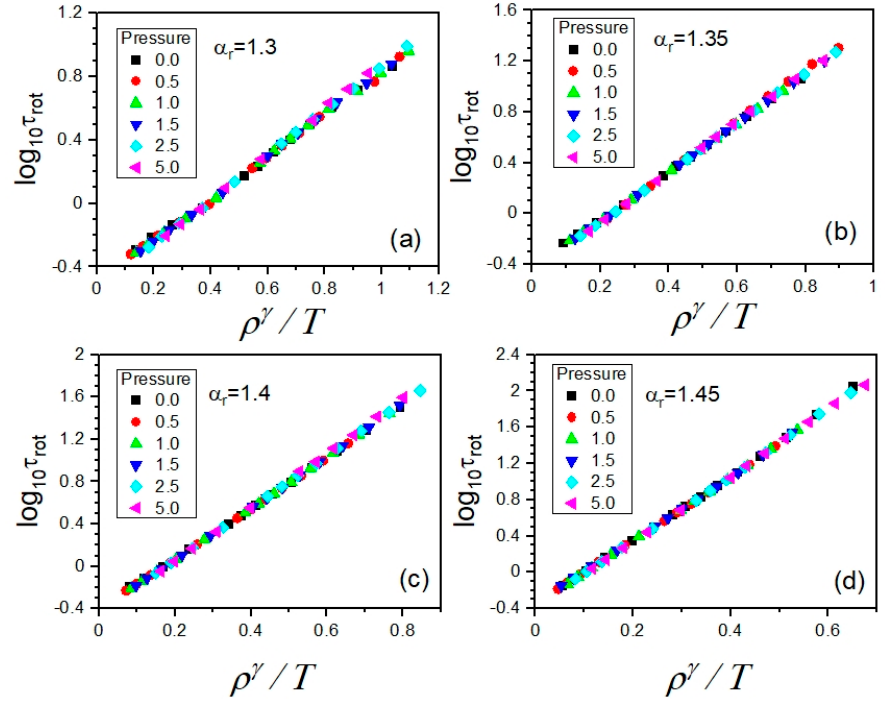
Figure 9. Density scaling of the isobaric dependences of rotational relaxation times τ rot for different anisotropy aspect ratios α r in the supercooled liquid state in the GB model. The values of the scaling exponent γ are the same as those yielding the high-quality density scaling of the rotational relaxa- tion times, which were determined from the density scaling criterion. In the separate panels, there are the cases shown for the different anisotropy aspect ratios α r : ( a ) 1.30, ( b ) 1.35, ( c ) 1.40, and ( d ) 1.45, respectively.